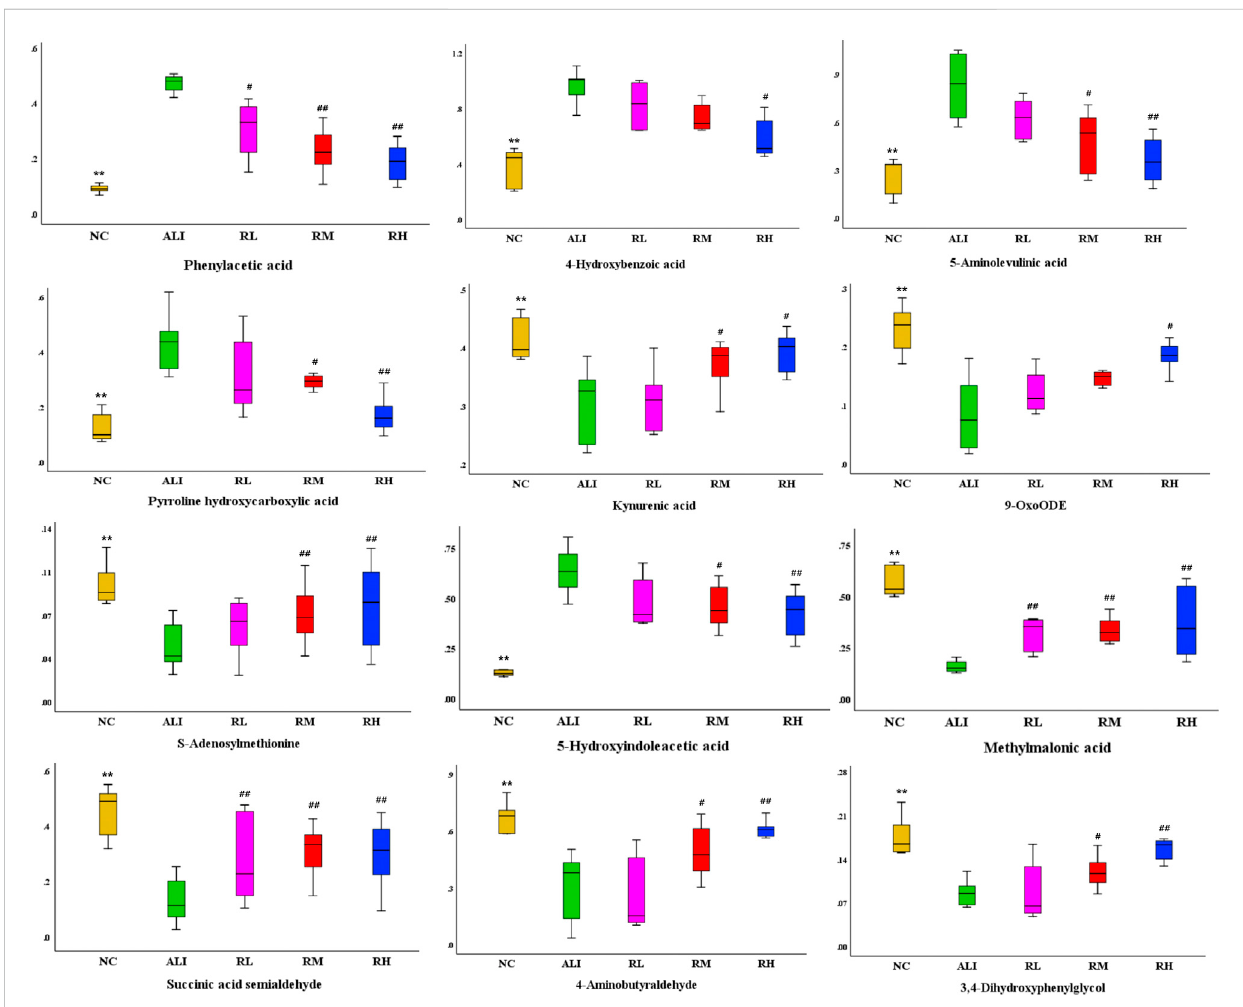
Variationsinthetrendsofthedifferencemetabolites.TherewereshownthevariationsinthetrendsofPhenylaceticacid,4-Hydroxybenzoicacid,5- Aminolevulinic acid, Pyrroline hydroxycarboxylic acid, Kynurenic acid, 9-OxoODE, S-Adenosylmethionine, 5-Hydroxyindoleacetic acid, Methylmalonic acid,Succinic acid semialdehyde, 4-Aminobutyraldehyde, 3,4- Dihydroxyphenylglycolrespectively. Compared with theNCgroup, * p < 0.05, ** p < 0.01; Compared with the ALI group, # p < 0.05, ## p <